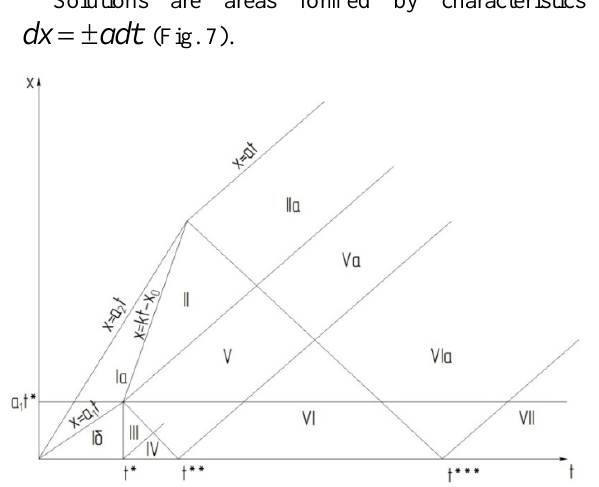
Fig. 7. Finding a solution.